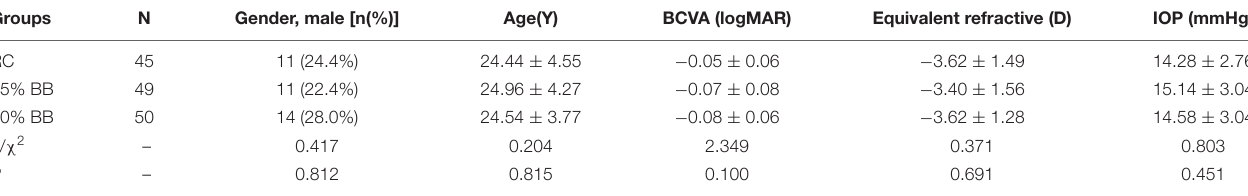
TABLE 2 | Demographic information and baseline data of participants in three groups. Groups